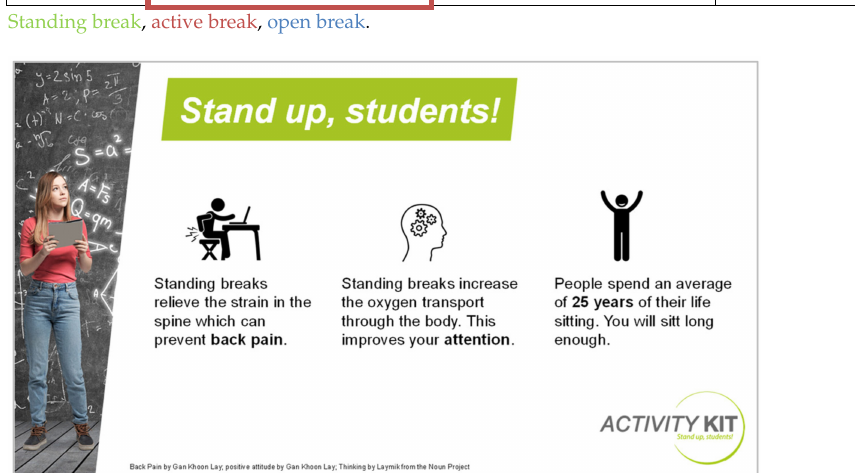
Standing break, active break, open break. Table 2. Intervention and control groups.